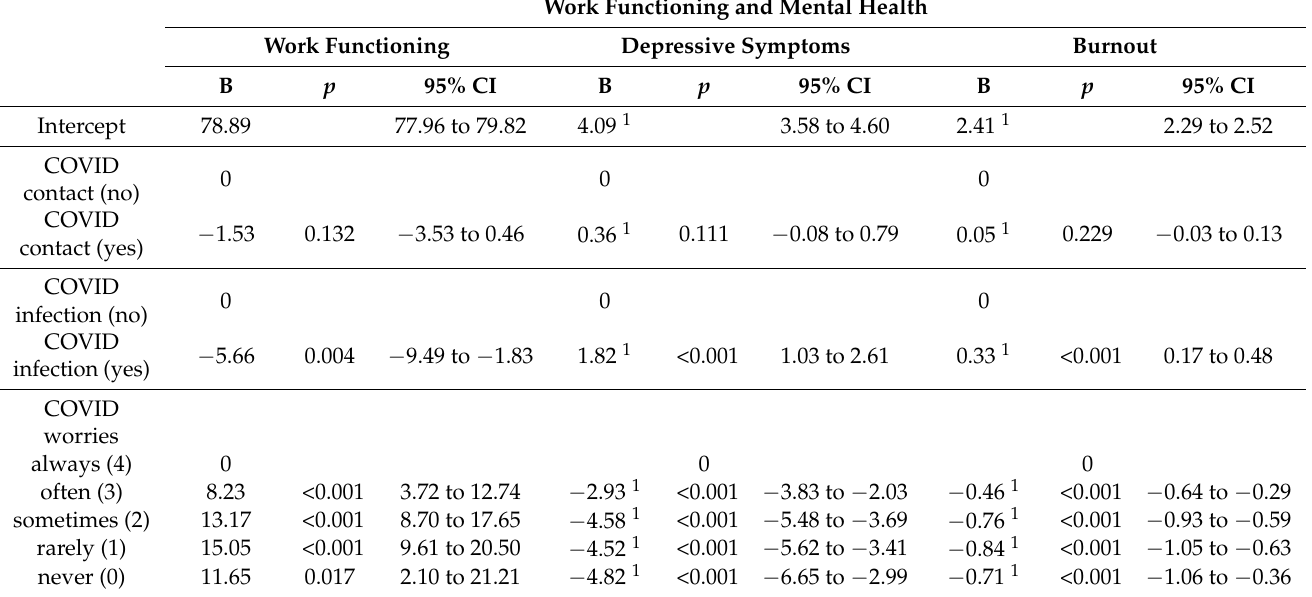
Table 3. Differences between nursing home staff with and without COVID contact or COVID infection and across different levels of COVID worries in work functioning and mental health.